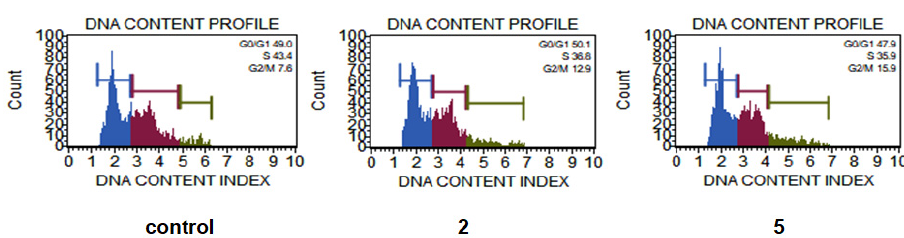
Figure 7. HCT-116 cell cycle analysis after treatment with compounds 2 and 5 . Concentration of compounds IC 50 ( μ M).